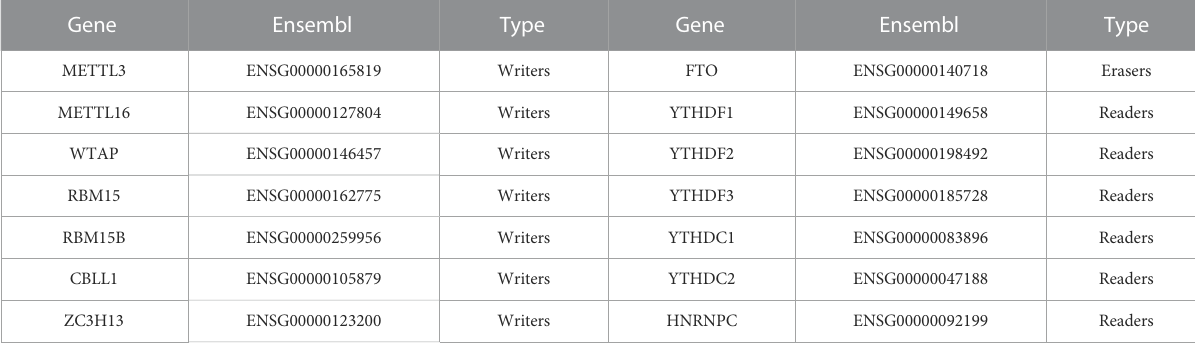
TABLE 1 The description of 14 m6A RNA methylation regulators from the Ensembl database. Gene Ensembl